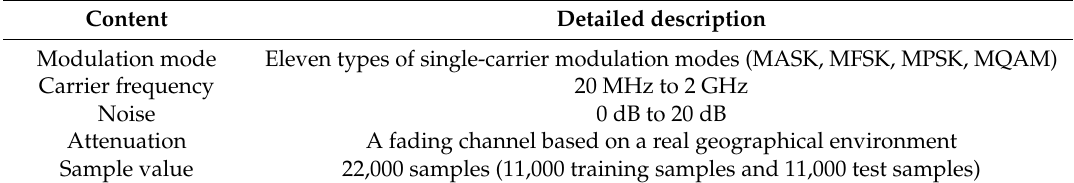
Table 1. Dataset